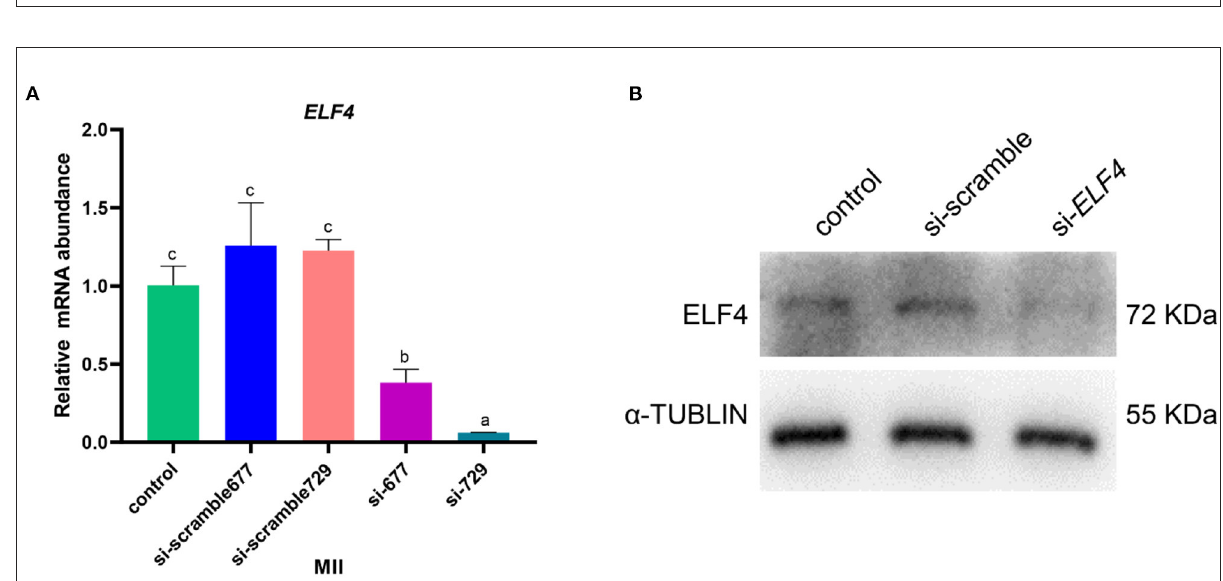
FIGURE1 Expression profile of ELF4 in pigs. (A) Expression levels of ELF4 in early IVF embryos. (B) Expression analysis of ELF4 in different tissues. Different lowercase letters indicate statistical differences ( p < 0.05).